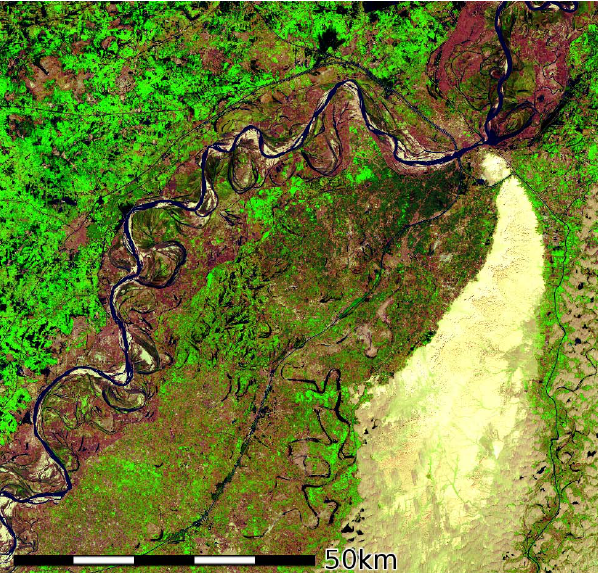
Fig. 9. Landsat composite colour image of the Indus and its flood- plain southwest of Sukkur. The Nara canal is seen running north- south to the right of the